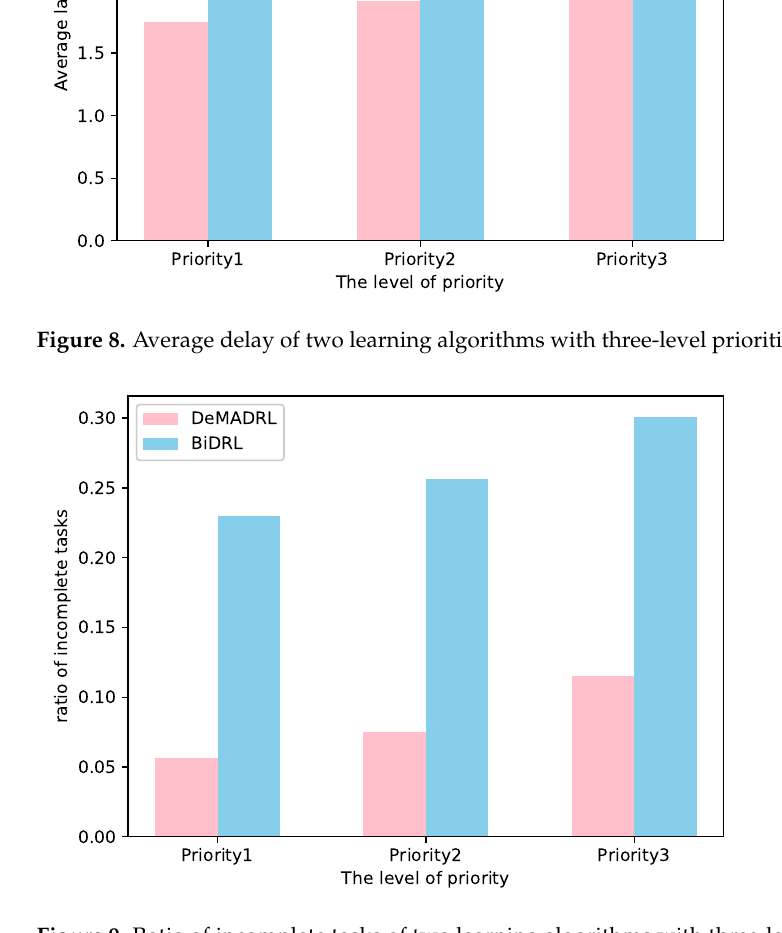
Figure 9. Ratio of incomplete tasks of two learning algorithms with three-level